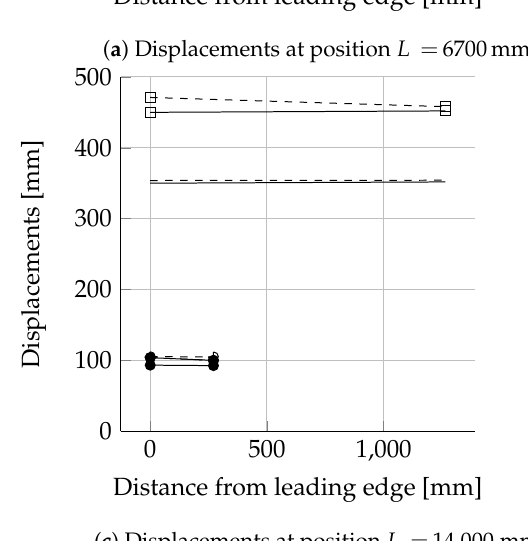
( d ) Displacements at position L = 17,700 mm.